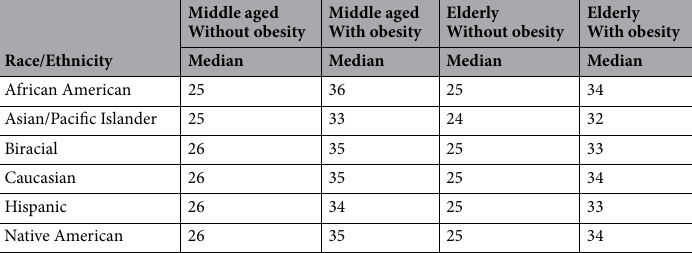
Table 3. Median BMI across race/ethnicity for each weight